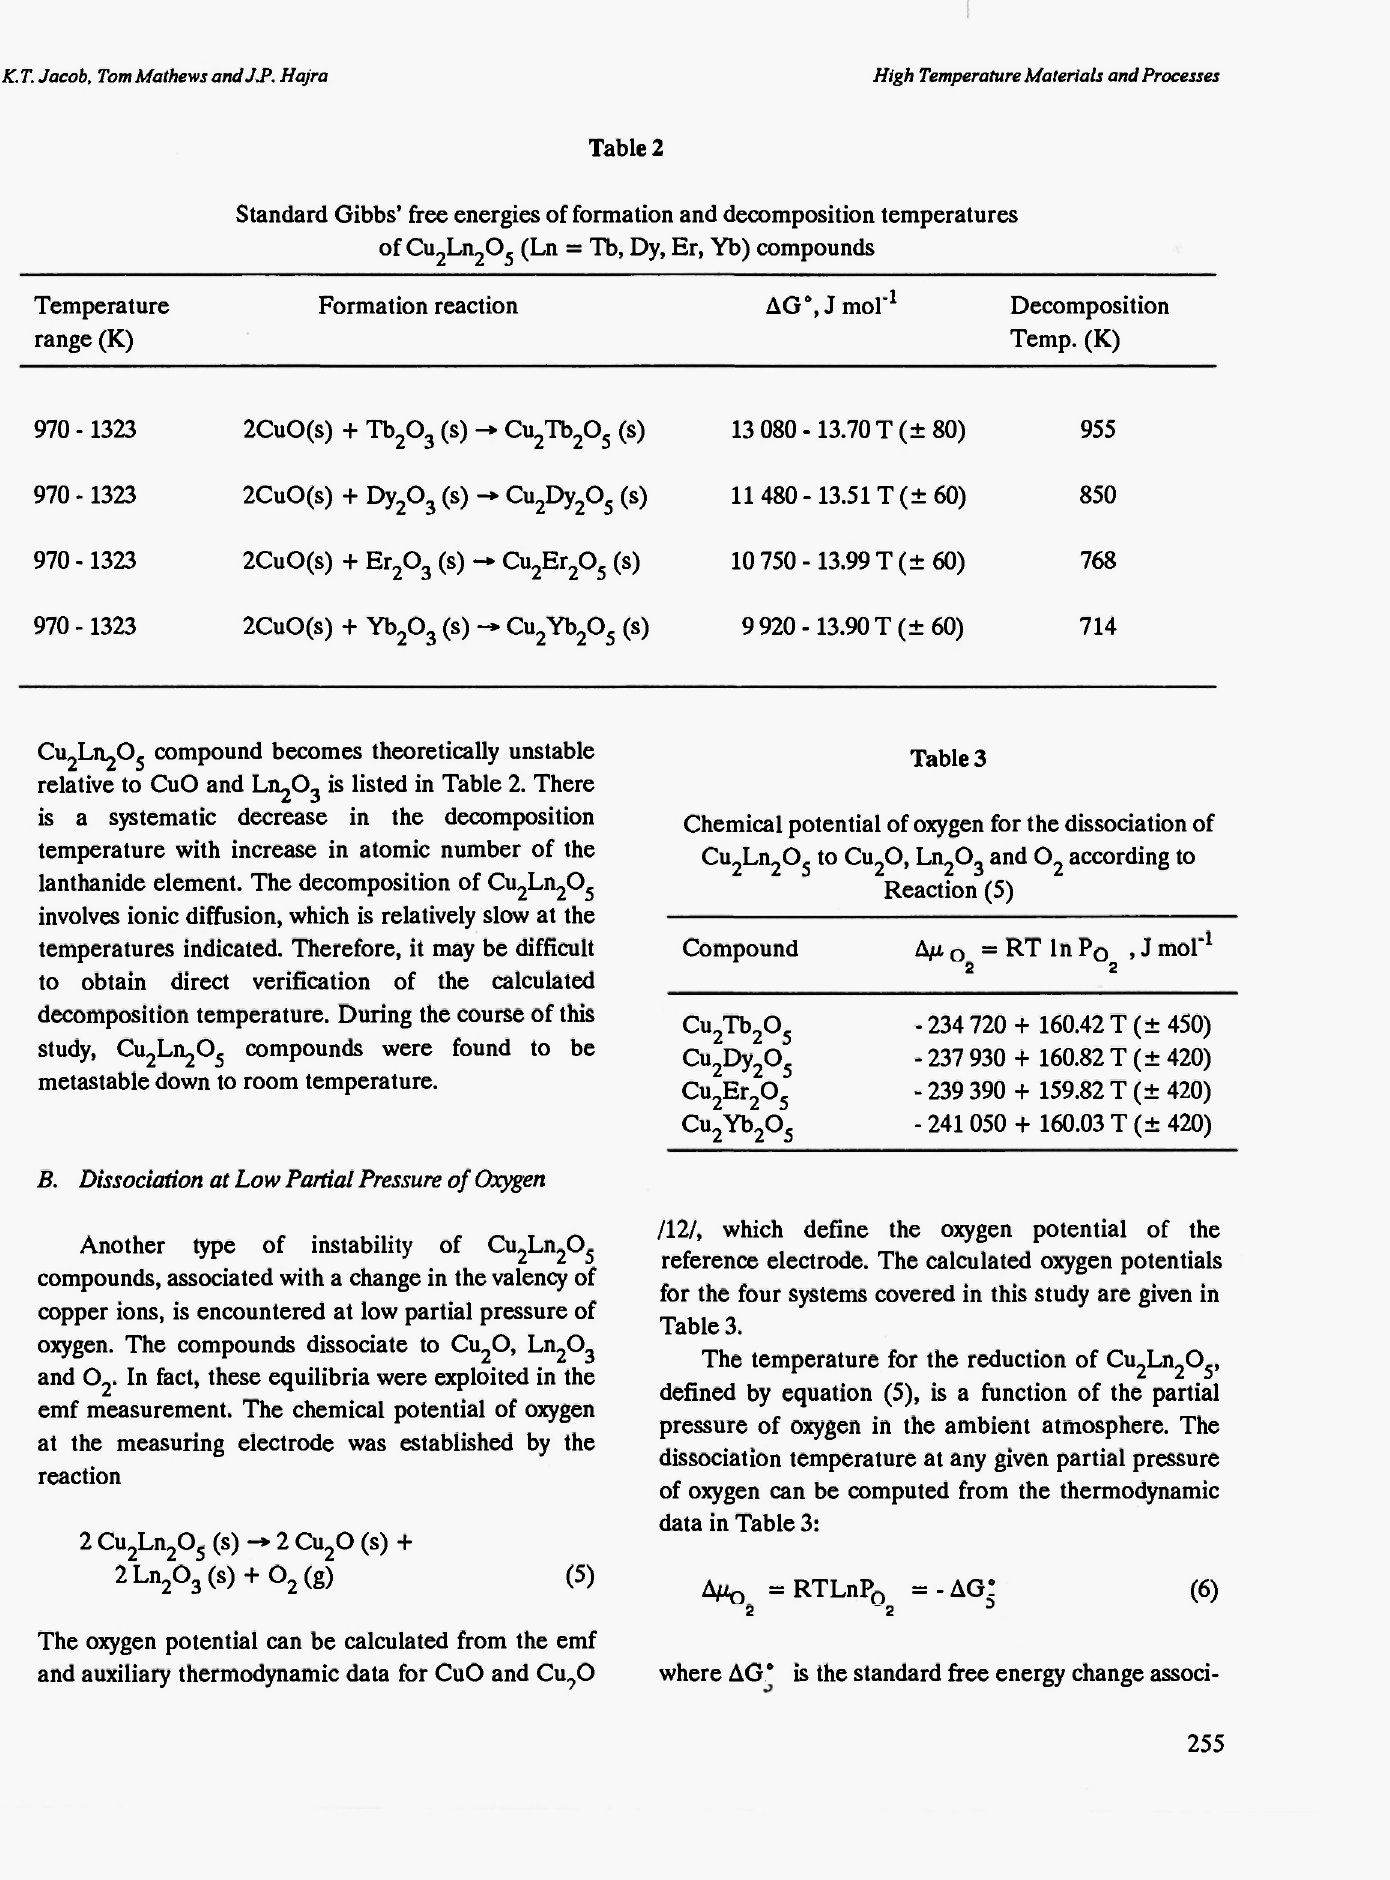
Standard Gibbs' free energies of formation and decomposition temperatures